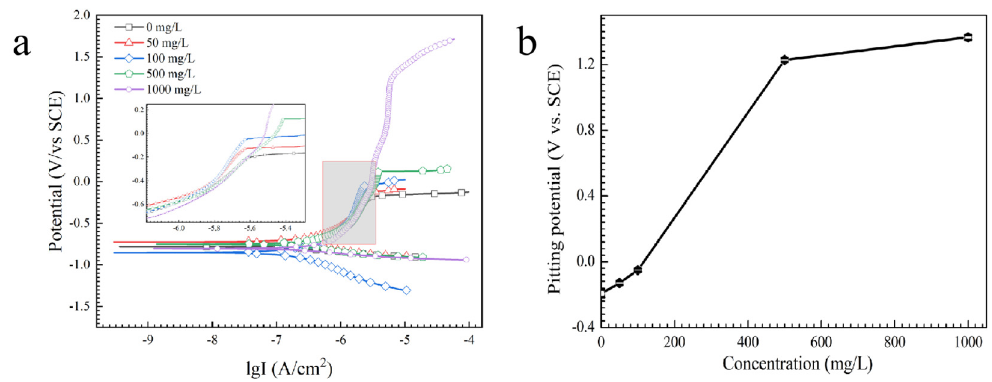
Figure 11. ( a ) Potentiodynamic polarization curves and ( b ) pitting potential of tin in the presence of various concentrations of Na 2 HPO 4